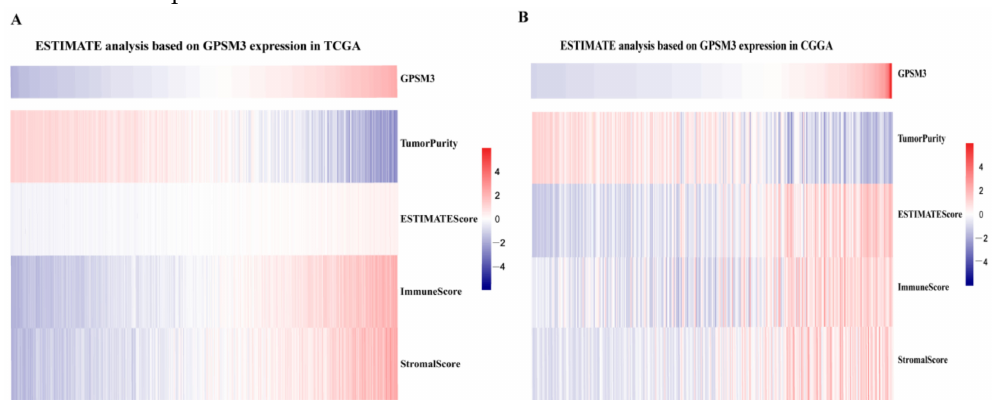
Figure 4. The ESTIMATE analysis of GPSM3 in LGG patients. ( A ) GPSM3 was positively related to the Stromal scores and ESTIMATE scores, but negative related to the Tumor purity in the TCGA dataset. ( B ) GPSM3 was positively related to the Stromal scores and ESTIMATE scores, but negative related to the Tumor purity in the CGGGA